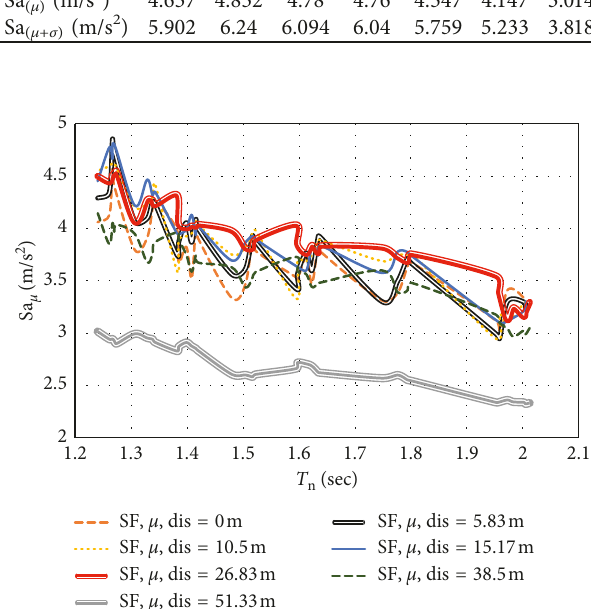
Figure 12: Average spectral accelerations for models with the presence of a tunnel (SF) at distances of zero, 5.83, 10.50, 15.17, 26.83, 38.5, and 51.33 meters from the center of the tunnel pro- jection onto the ground surface and their